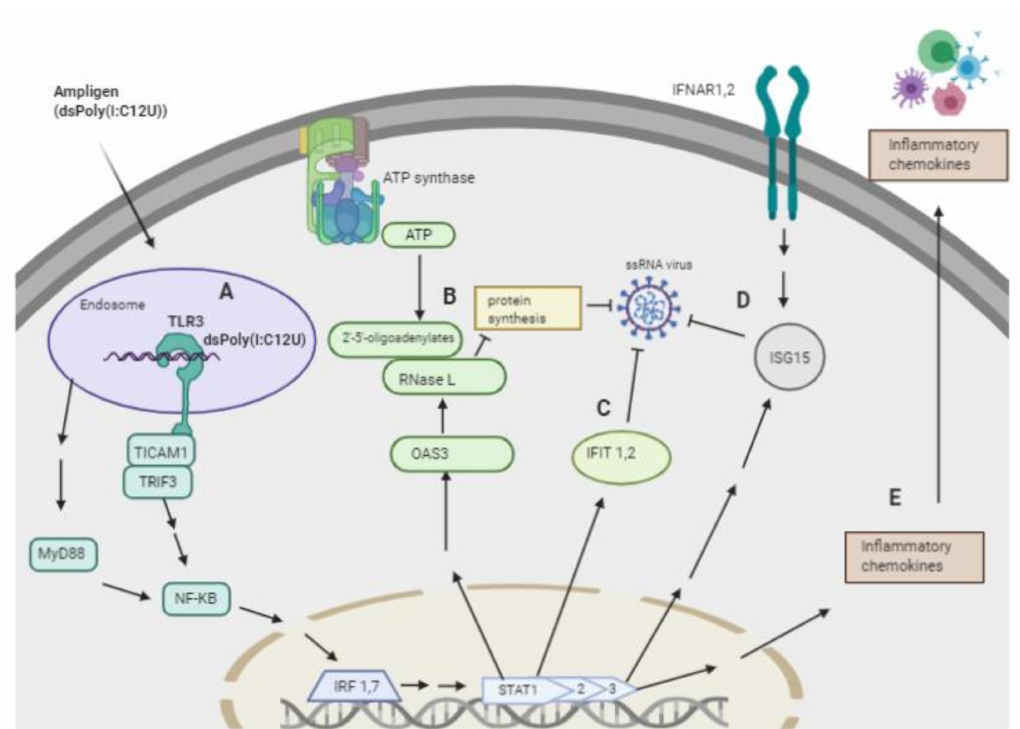
Figure 4. Schematic presentation of the overexpressed genes and the antiviral pathways activated by Rintatolimod. Rintatolimod (Ampligen; dsPoly (I: C12U)) enters the cells and targets the TLR3 in the endosome to start a cascade of actions. A—Stimulation of TLR3, which activates TICAM1 and TRIF3 that are involved in innate immunity against pathogens. Activation of TICAM1 and MyD88 mediate NF-kB expression that subsequently activates transcription factors such as IRF1 and IRF7. Interferon Regulatory Factors activate STAT1, 2, and 3 that stimulate the innate and acquired immune responses, mediate cellular responses to interleukin, and regulate inflammatory responses to infection. B—Activation of STAT1 and 2 upregulate the expression of OAS3, which induces the synthesis of 2 (cid:48) ,5 (cid:48) -oligoadenylate (2–5 A) from ATP upon binding of dsRNA. 2–5 A activates RNase L, causing endonucleolytic cleavage of viral ssRNAs and blocking virus replication. C—TLR3 activation induces the expression of members of the IFIT family. The upregulation of IFIT1 and IFIT2 result in restriction of ssRNA virus replication in the cytosol. In addition, the IFIT family restricts virus replication through an alternation of protein synthesis and the ability of an antiviral protein to bind viral RNA directly. D—Activation of STAT 1, 2, and 3 activate the expression of interferon stimulatory genes (ISGs) like ISG15, which induces the antiviral state in the cytosol. ISG15 acts on ssRNA and directly degrades viral RNA. Treatment with Rintatolimod increased the expression of IFNAR1 and IFNAR2, which recognize interferon and activate JAK/STAT signaling pathways. E—Activation of STAT signaling pathways leads to the production of various cytokines, which results in the activation of the adaptive immune system. The pathway image was created with